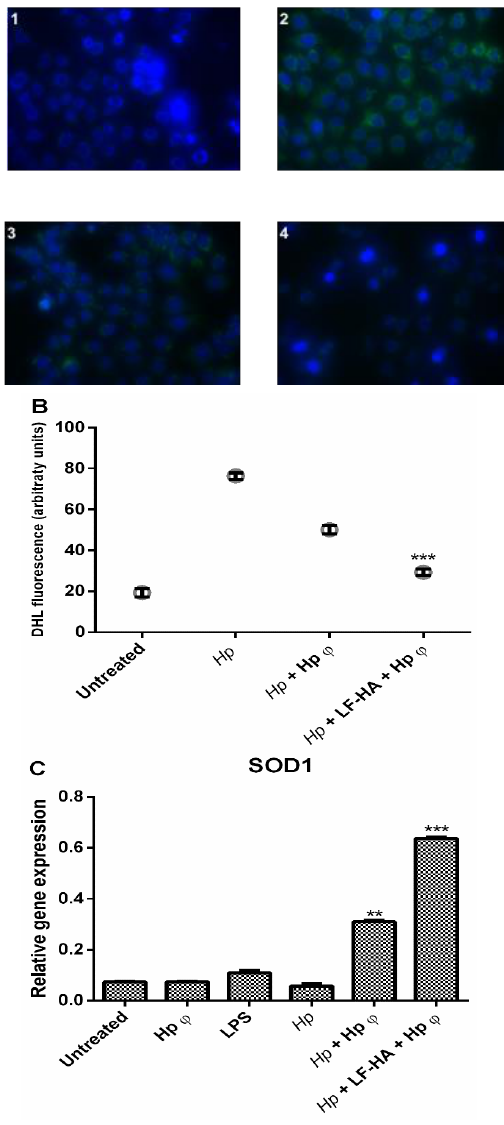
Figure 6. Effect of Hp φ + LF-HA on ROS production. ( A ) DHR-loaded cells differently treated (1 untreated cell; 2 Hp ; 3 Hp + Hp φ; 4 Hp +LF-HA + Hp φ), observed with a Leica DMI6000 fluorescence microscope equipped with Metamorph Imaging Software (Leica MetaMorph © AF, Wetzlar,